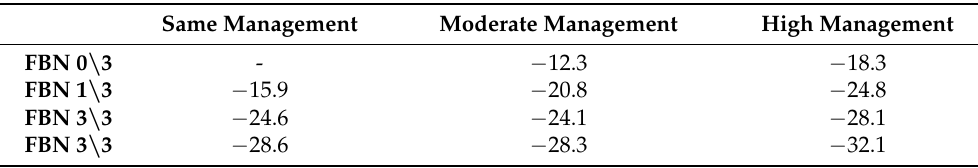
Table 4. Variation in the total estimated burned area (%) compared to the BAU option. FBN stands for fuel break